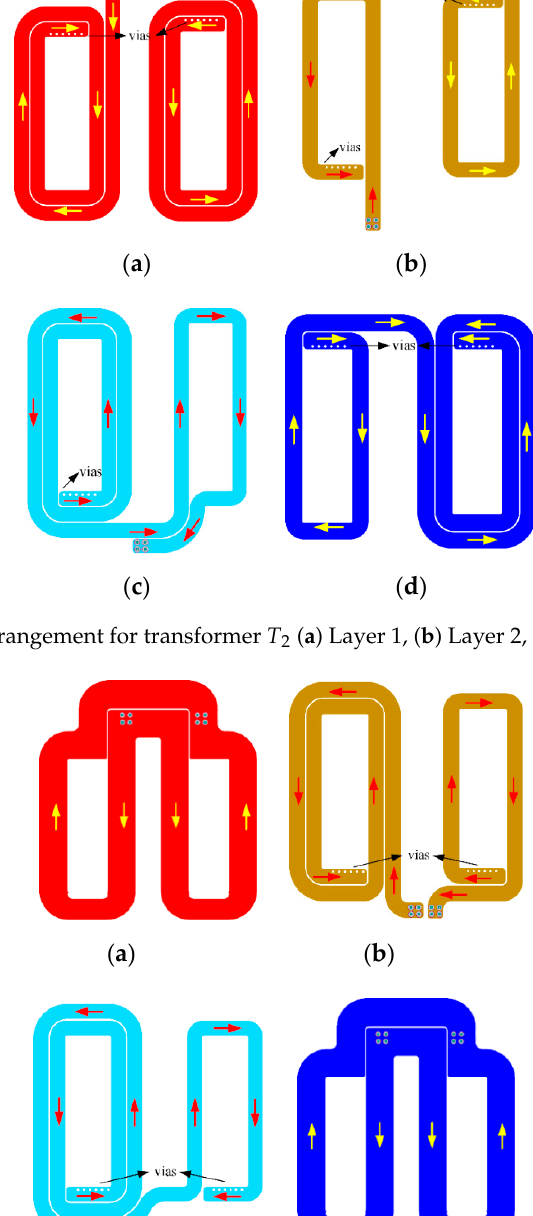
Figure 8. Integration scheme of T 1 .